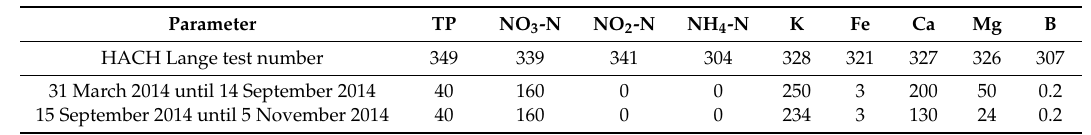
Table 1. Targeted levels (mg · L − 1 ) for each measured parameter in the aquaponic system, and the corresponding HACH Lange LCK test